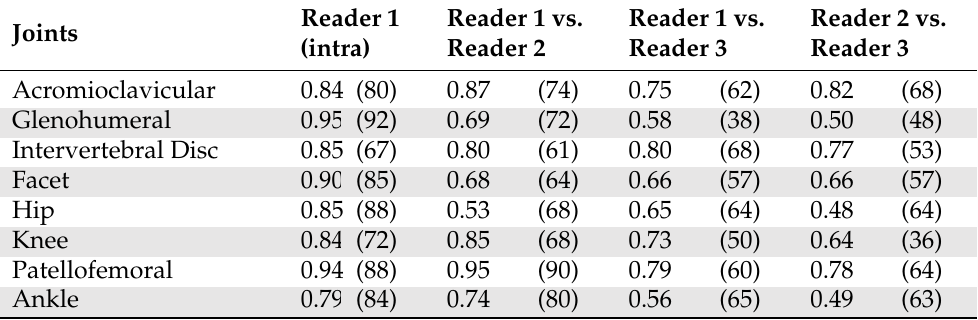
Table 3. Intra- and interobserver reliability as weighted kappa (percentage of absolute agreement) for OACT scores for individual